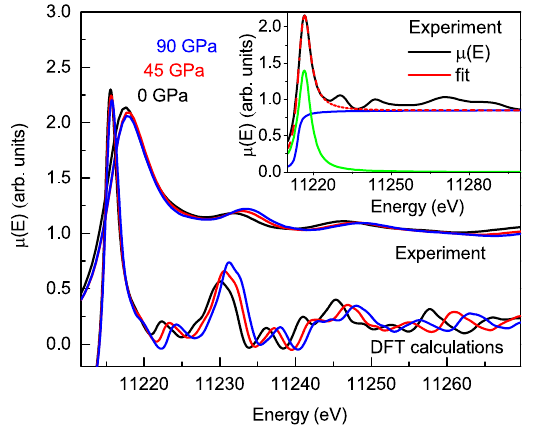
Figure 3. Experimental (simulated) x-ray absorption spectroscopy (XAS) spectra at ambient pressure, at 45 GPa and 90 GPa in black line, red line and blue line, respectively. The Lorenztian + arctang fit of the WL (experimental spectrum at room pressure) is represented in the inset. Red dash line is the total fit of the WL, the blue line corresponds to the arctangent fit function and the clear green line is the lorenztian fit function.